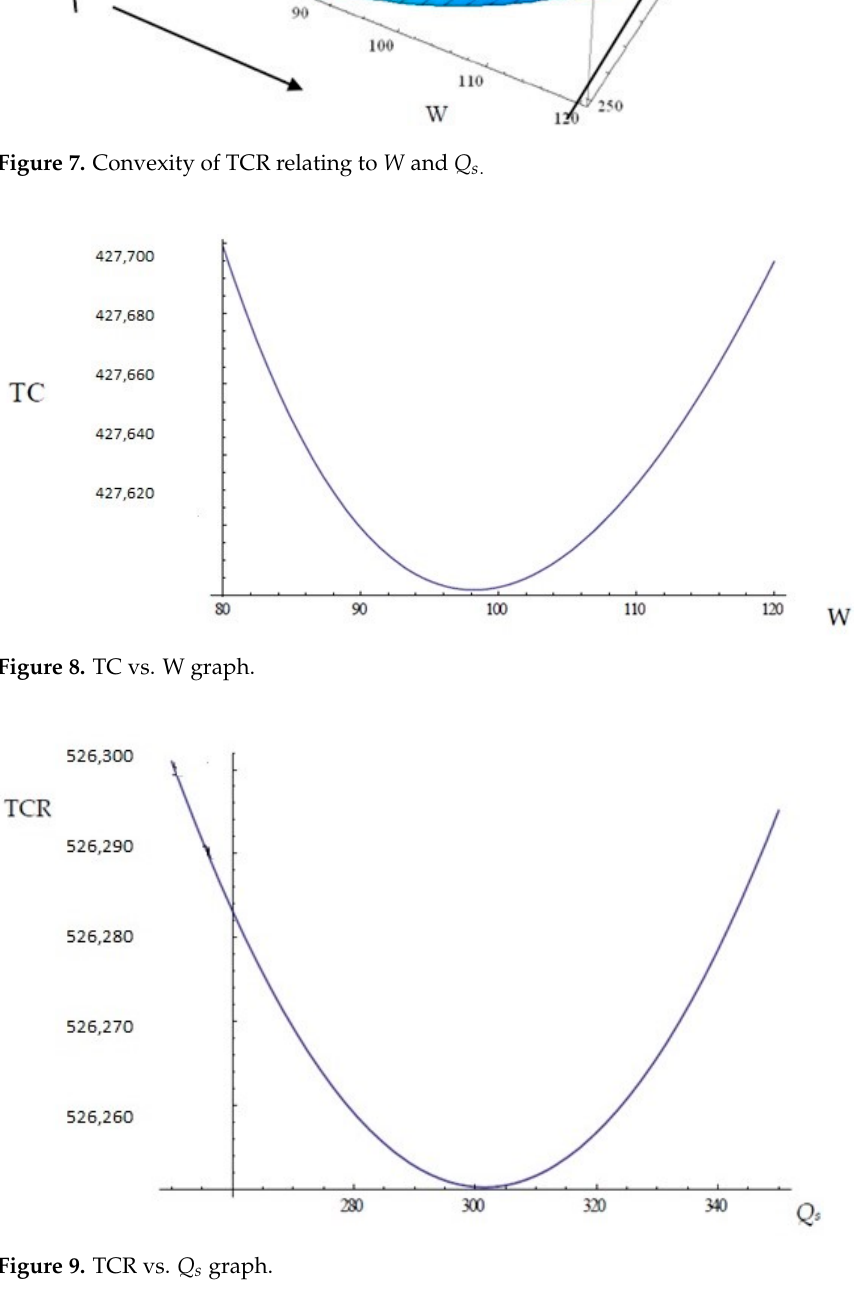
Figure 9. TCR vs. Q s graph.